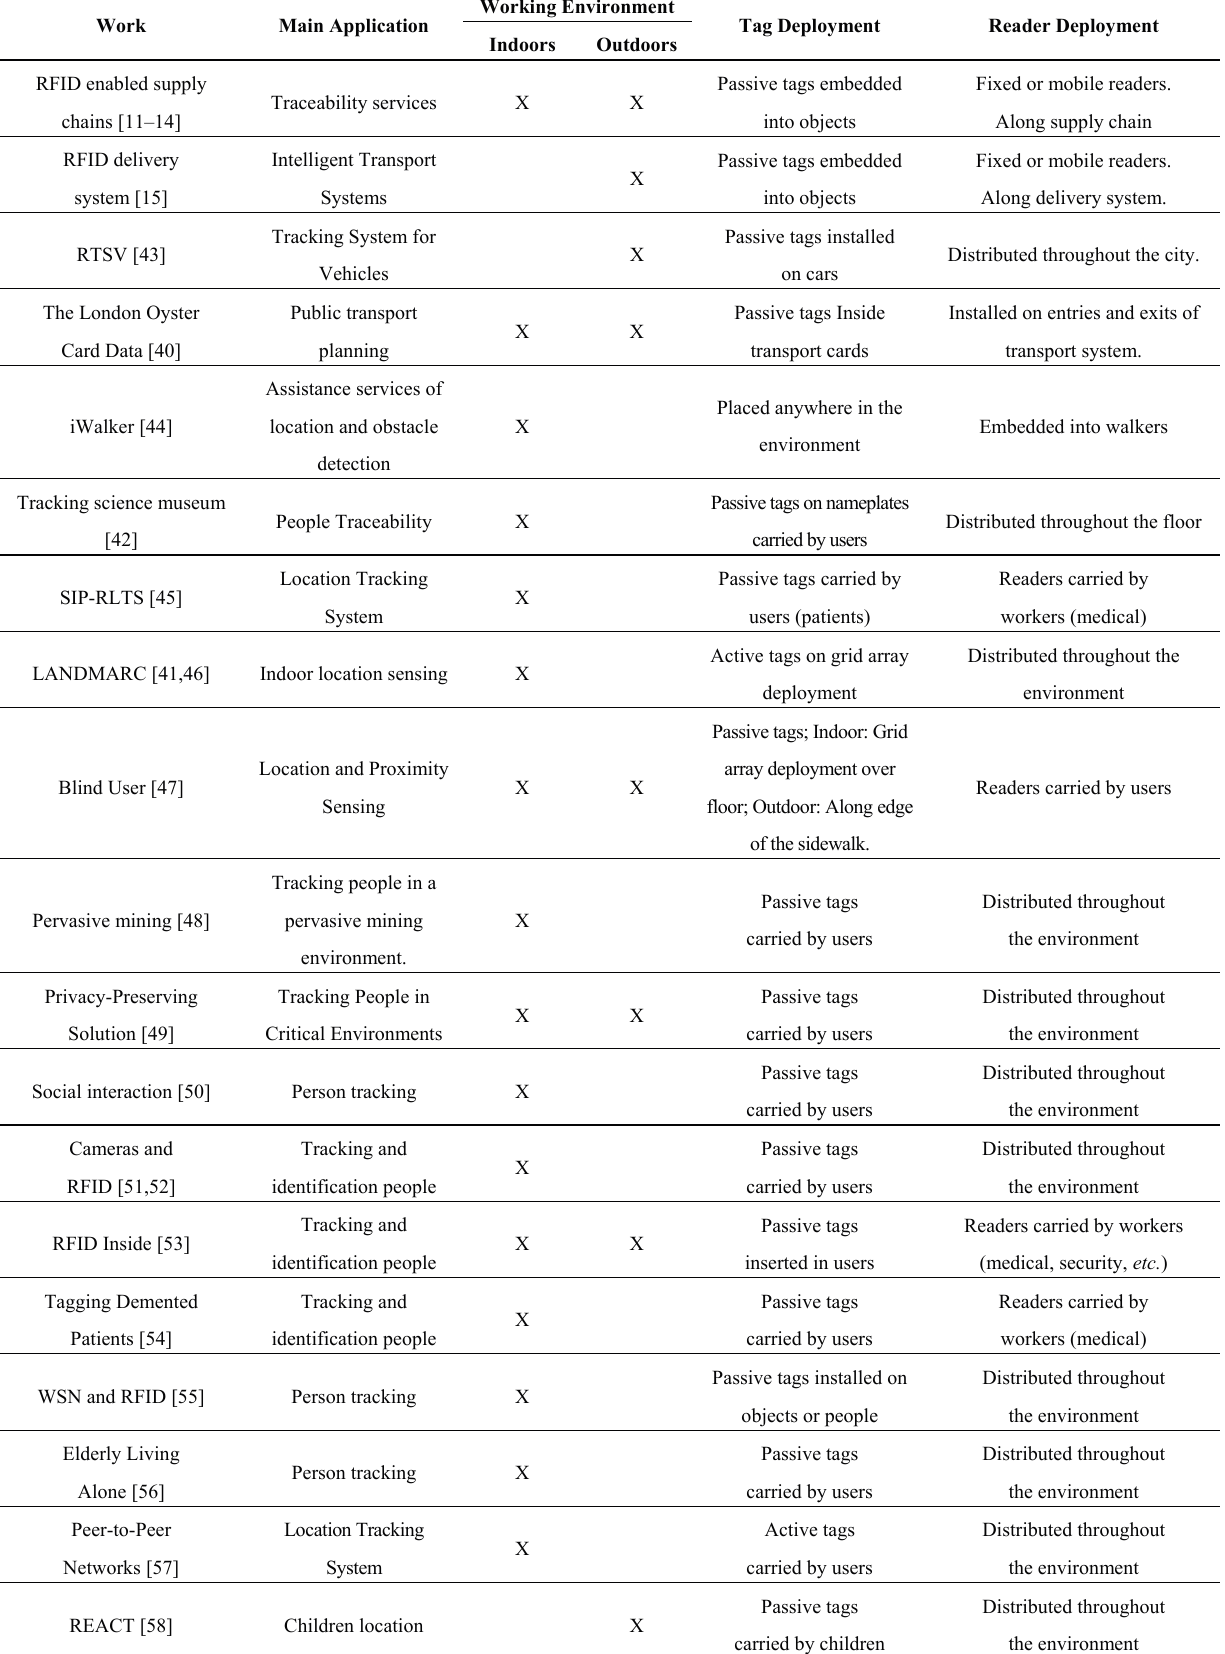
Table 1. RFID-based track and trace